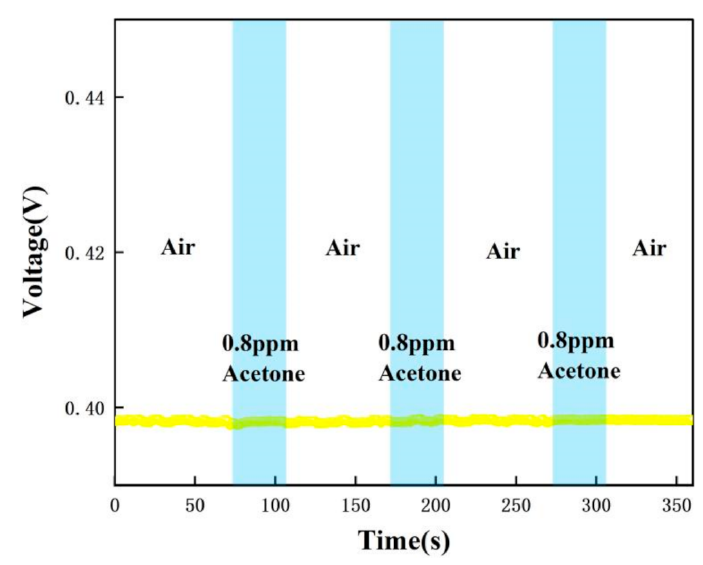
Figure 14. Test result of 0.8 ppm